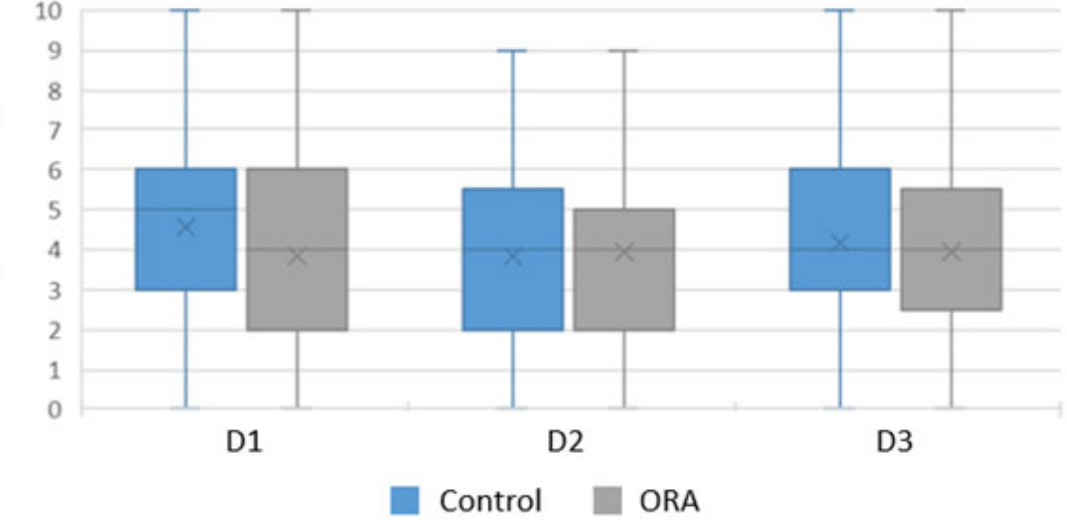
Figure 1. Pain assessment over the first 72 h. ORA: opioid reduced anesthesia; D: postoperative day. Pain was mainly localized at the cervical and facial area (81%), followed by the flap harvest site (43%), and then the tracheostomy (26%) (Figure 2).